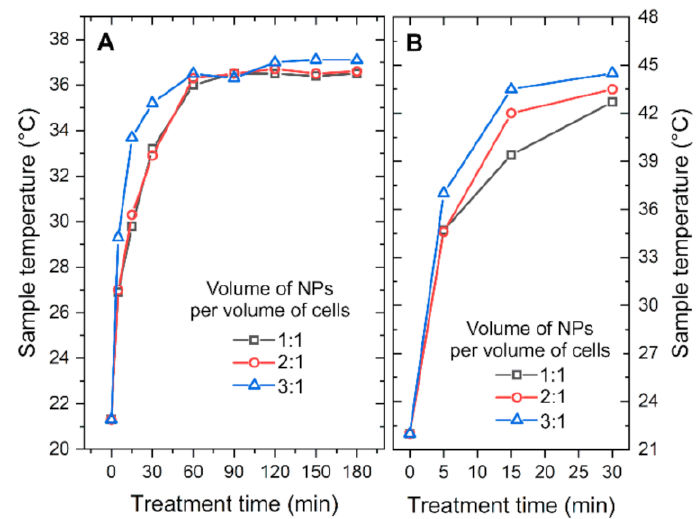
Figure 5. Measured dependence of sample temperature on concentration of nanoparticles and treat- ment time. ( A ) 100 kHz low magnetic field generator and ( B ) 200 kHz high magnetic field generator.